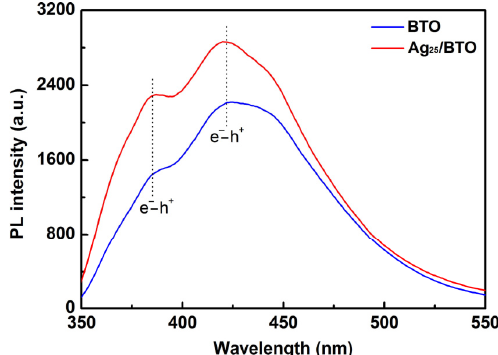
Fig. 8 PL spectra of the monolithic BTO and Ag 25 /BTO thin films with an excitation wavelength of 335 nm at room